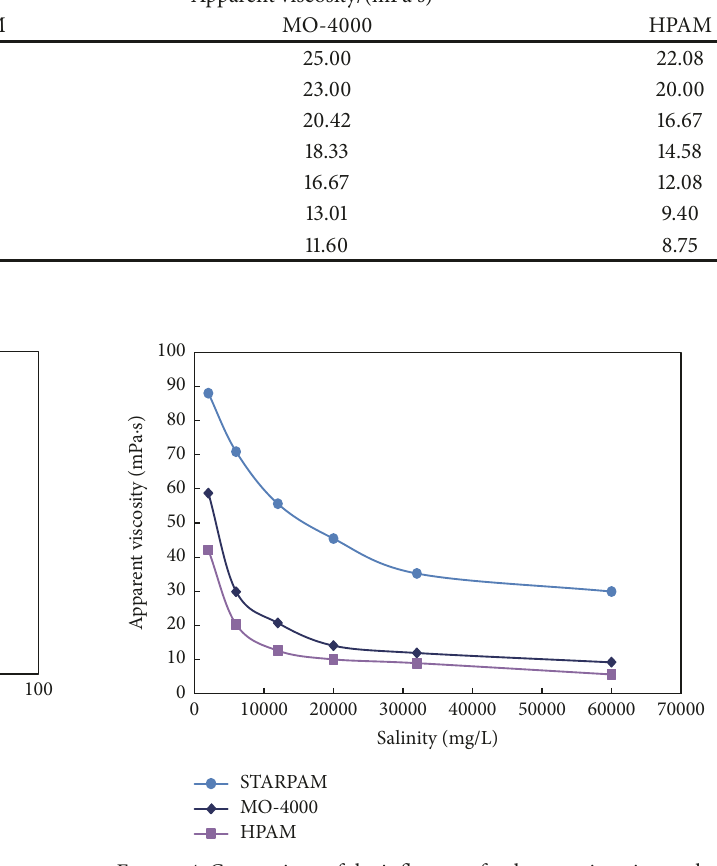
Figure 4: Comparison of the influence of polymers viscosity on the